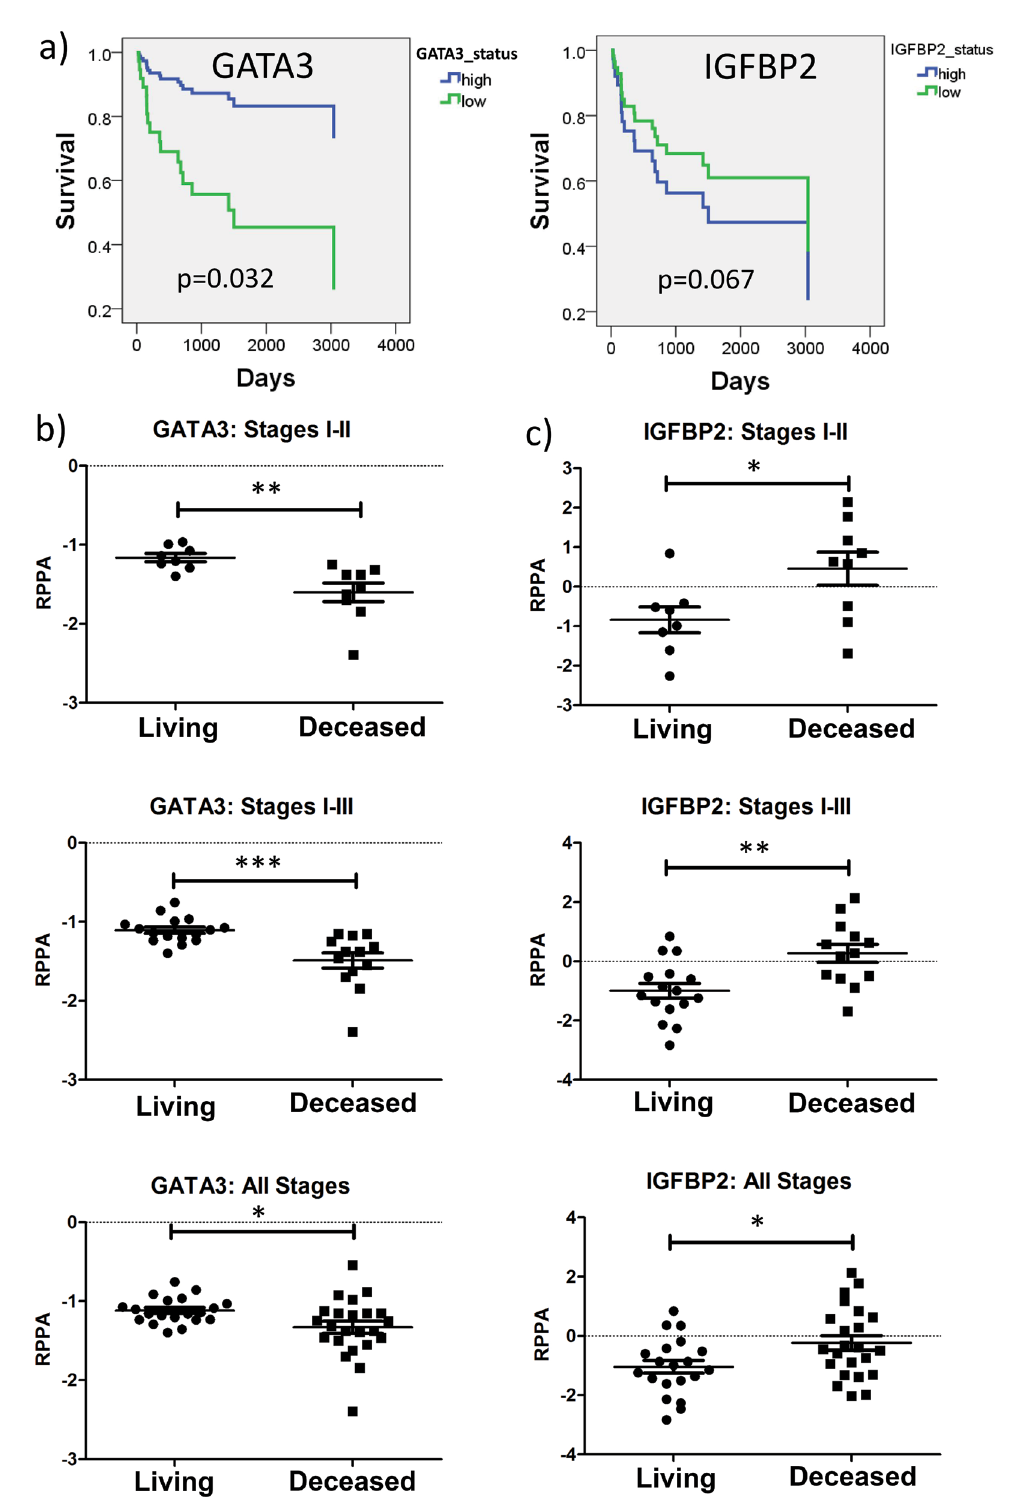
Figure 2. Survival analysis of selected proteins in TCGA data. ( a ) Stage-adjusted survival plots for GATA3 and IGFBP2. ( b ) and ( c ) Comparison of RPPA-determined expression in living and deceased patients for GATA3 ( b ) and IGFBP2 ( c ). IGFBP2 expression is significantly increased in deceased patients in Stages I-II, I-III, and I-IV, while GATA3 is significantly decreased in deceased patients in Stages I-II, I-III, and I-IV. *p<0.05, **p<0.01,